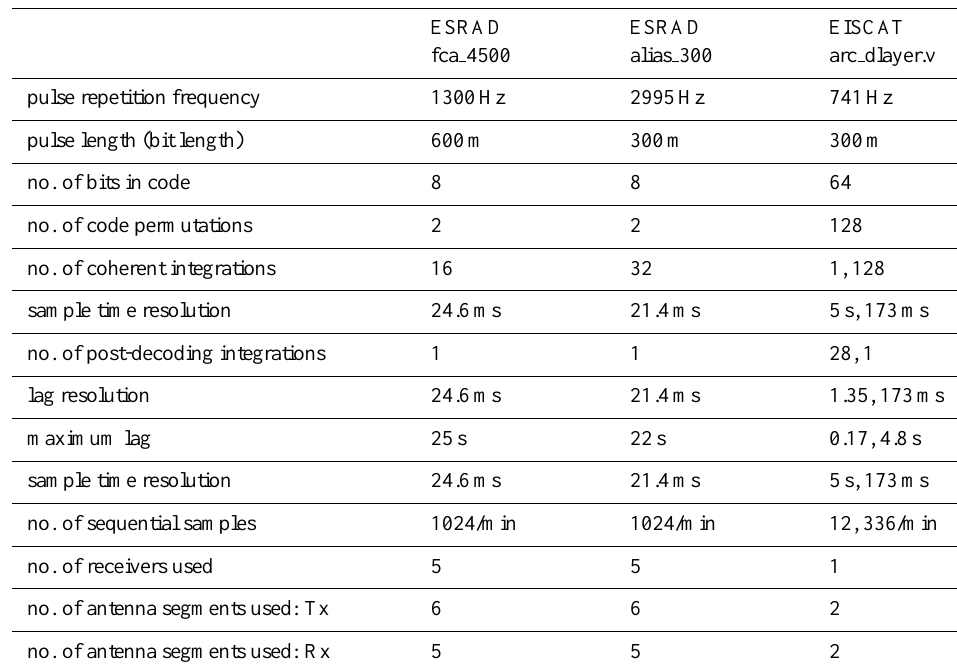
Table 2. Radar operating modes 10 November